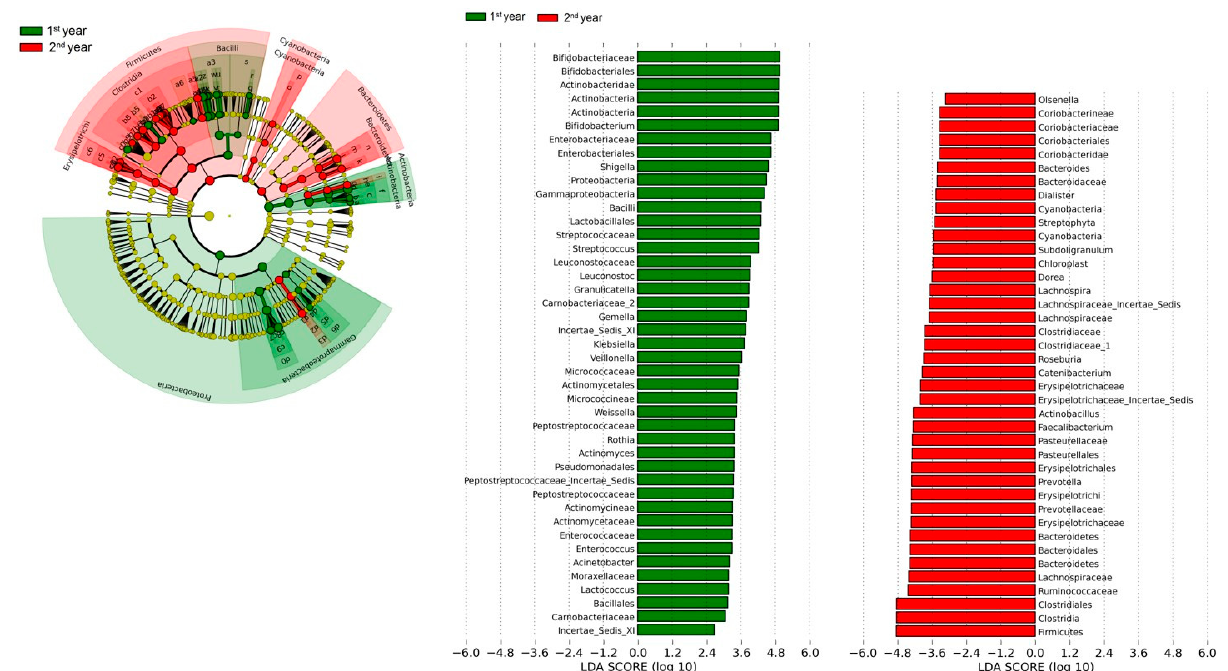
Figure 6. Differentially abundant taxa in the first and second years of life: Differentially abundant taxa at all taxonomic levels between the gut microbiota of all children in rural and urban locations in all intervention arms combined between the first and second years of life were assessed using the LEfSe algorithm.